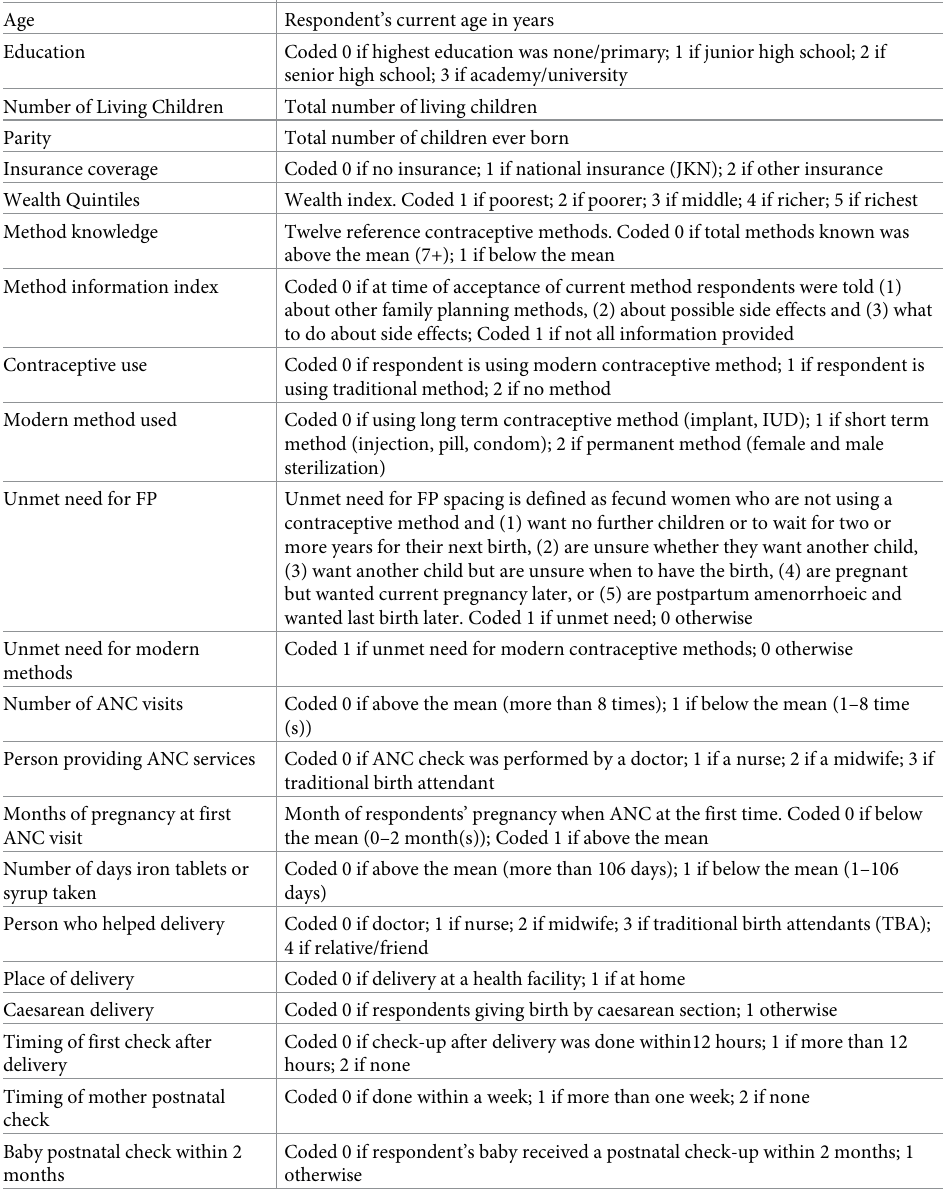
Table 1. Operational definitions of variables used in the